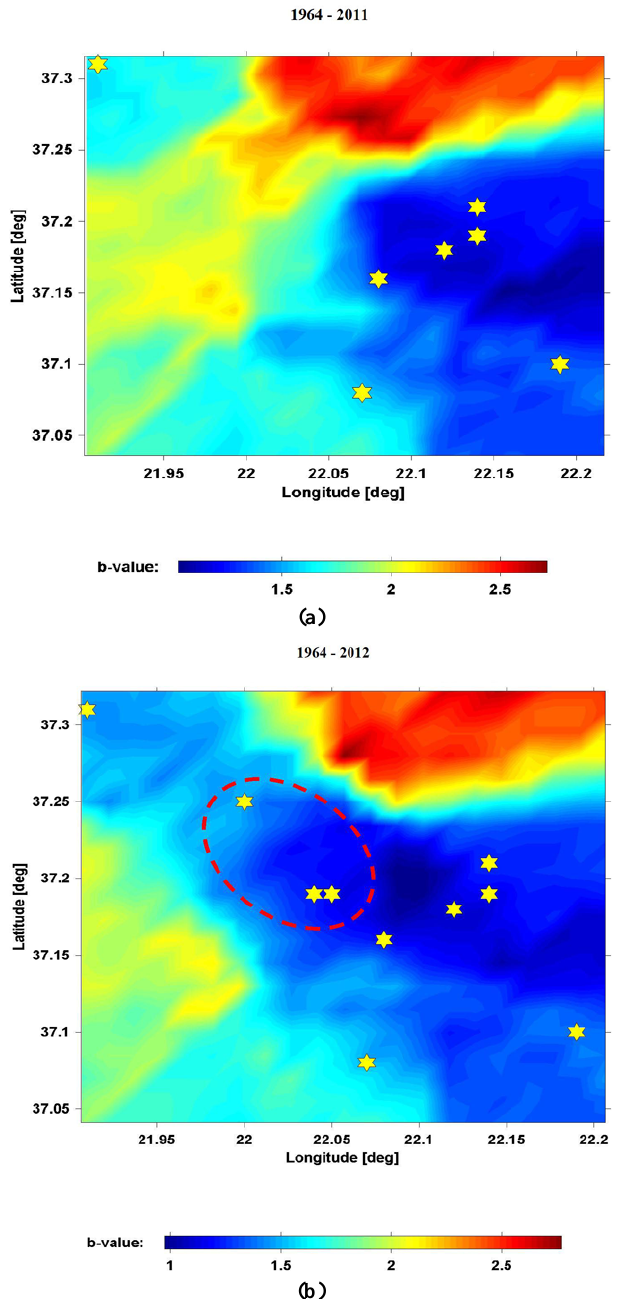
Fig. 4. B-value maps for the Messinia basin (a) prior to the 2011 seismic swarm, from 1964–2011 and (b) b-value map including the seismicity of the 2011 swarm. The yellow stars indicate the larger seismic events with M > 4 and the red ellipse shows the 2011 seis- micity swarm cluster containing the three largest earthquakes.